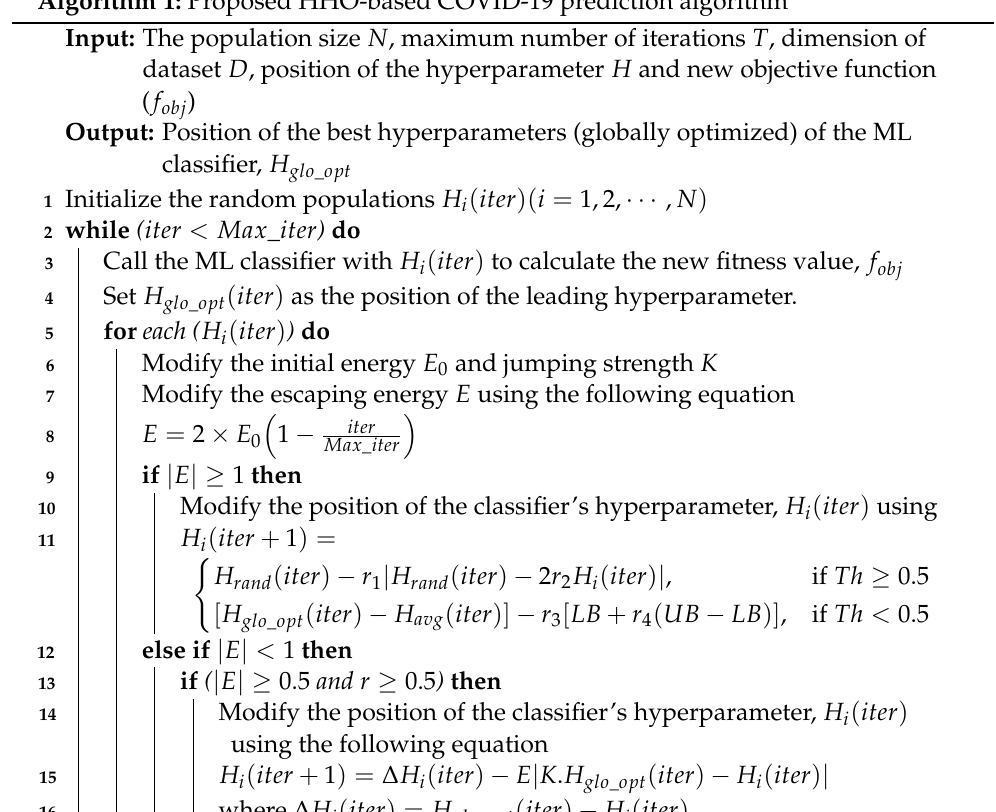
Algorithm 1: Proposed HHO-based COVID-19 prediction